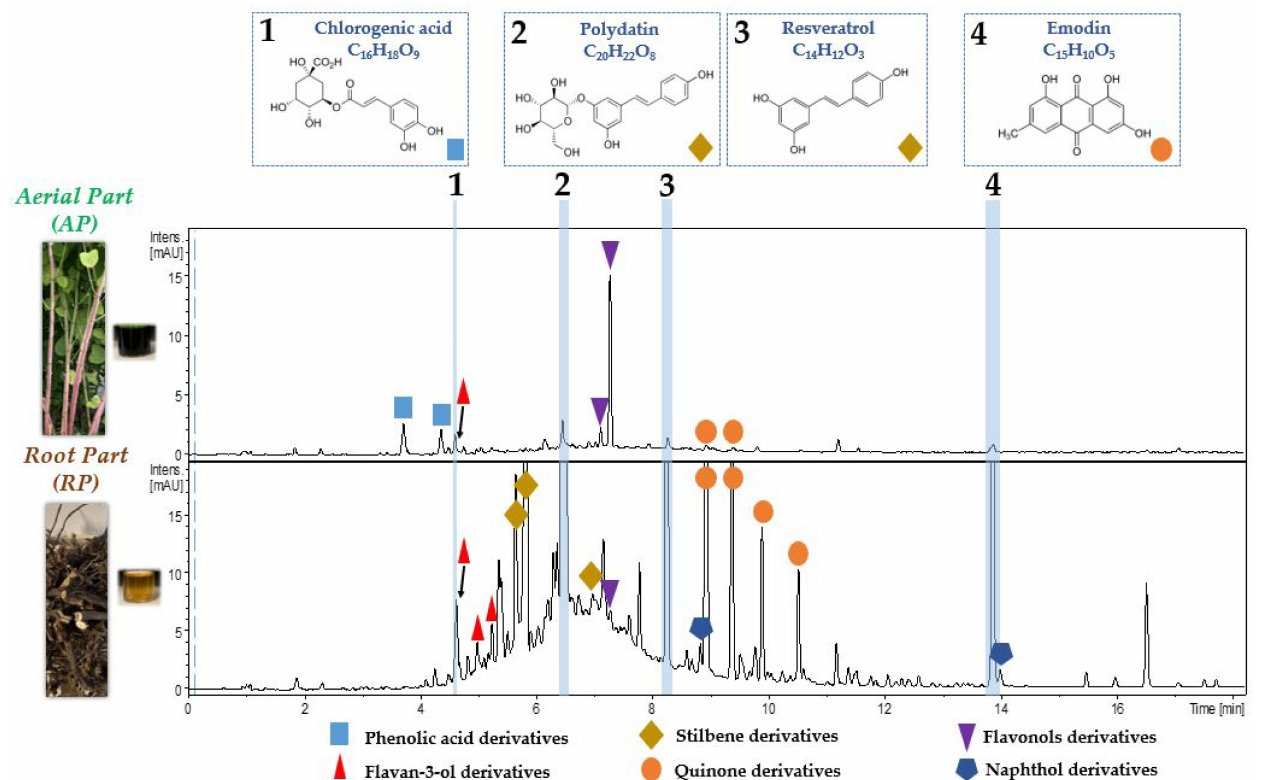
Figure 6. UV Chromatographic fingerprint analysis at 285 nm of AP and RP of invasive P. cuspidatum using UHPLC-UV-Q-TOF-HRMS/MS. Identifications of the four specialized metabolites of interest on the four enzymatic studied targets (hyaluronidase, elastase, collagenase and tyrosinase): chlorogenic acid (1), polydatin (2), resveratrol (3) and emodin (4). Other identified compounds corresponding to the derivatives were reported in Supplementary Materials, Table